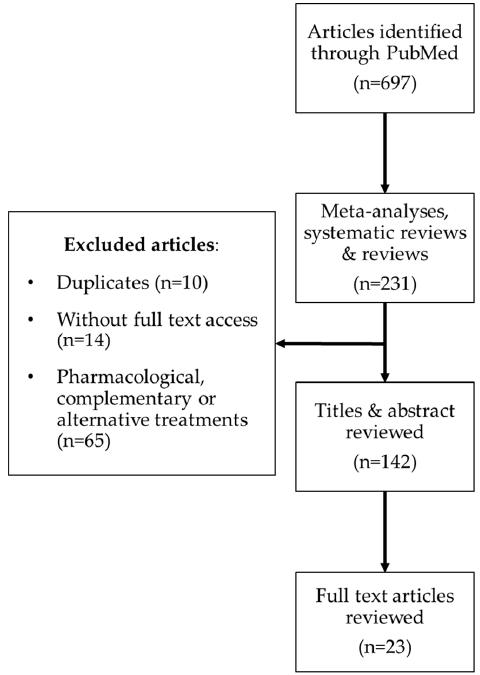
Figure A1. Searching flow chart for FM and CFS.